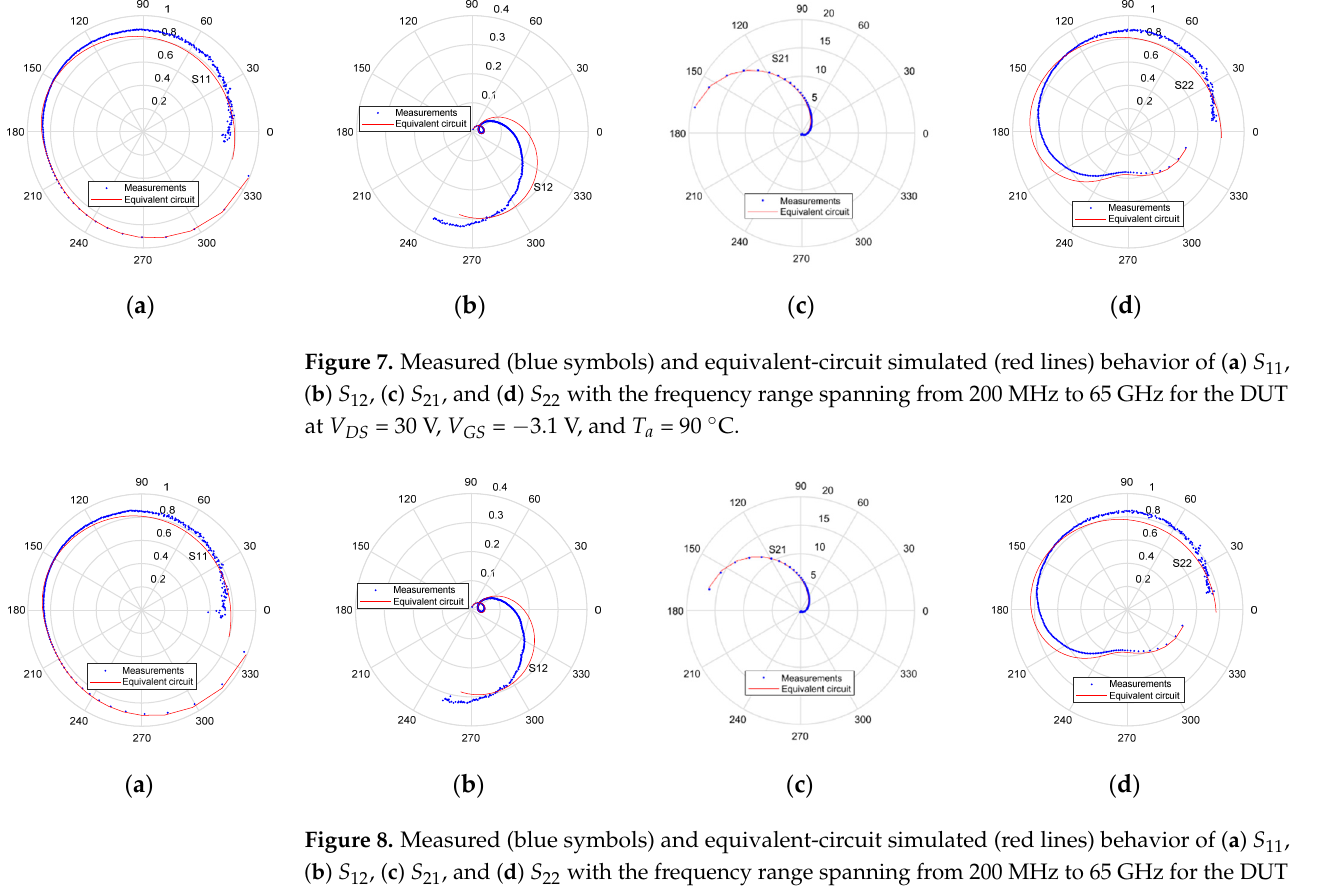
Figure 6. Measured (blue symbols) and equivalent-circuit simulated (red lines) behavior of ( a ) S 11 , ( b ) S 12 , ( c ) S 21 , and ( d ) S 22 with the frequency range spanning from 200 MHz to 65 GHz for the DUT at V DS = 30 V, V GS = − 3.1 V, and T a = 35 °C.